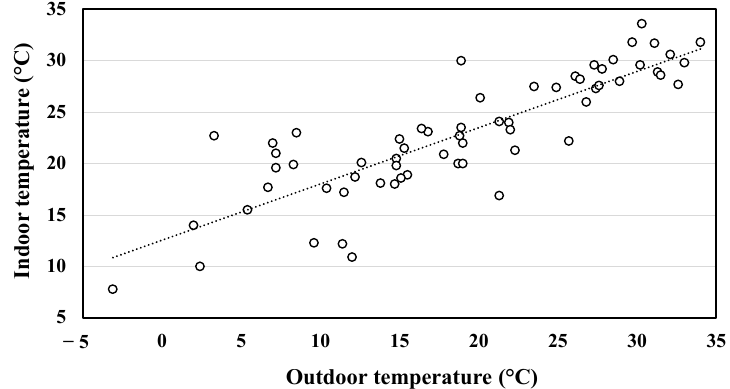
Figure 5. Correlation between indoor and outdoor temperatures.